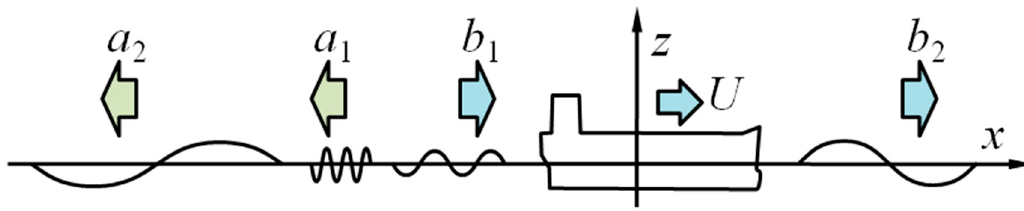
Figure 2. Wave systems for a forward-moving